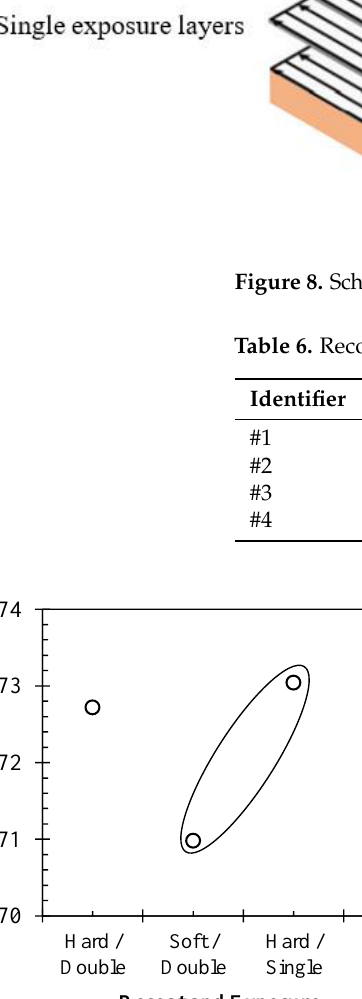
Figure 8. Schematic of laser scanning strategies, where ( a ) is single exposure and ( b ) is double ex- posure. Table 6. Recoat and exposure study.